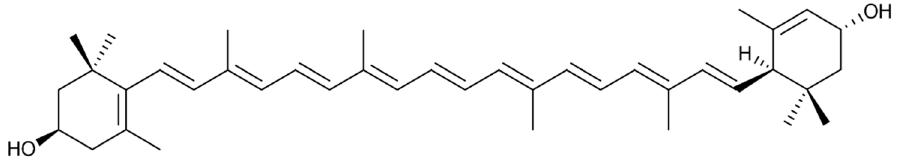
Figure 1. The structure of (all- E )-Lutein ((all- E ,3 R ,3 ′ R ,6 ′ R )-3,3 ′ -Dihydroxy- β , ε